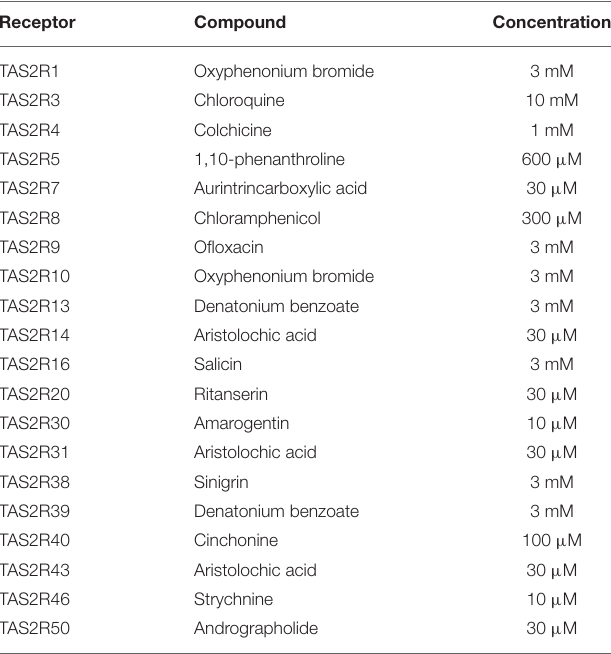
TABLE 1 | List of reference compounds used as agonists for the human TAS2R receptors in vitro assays.